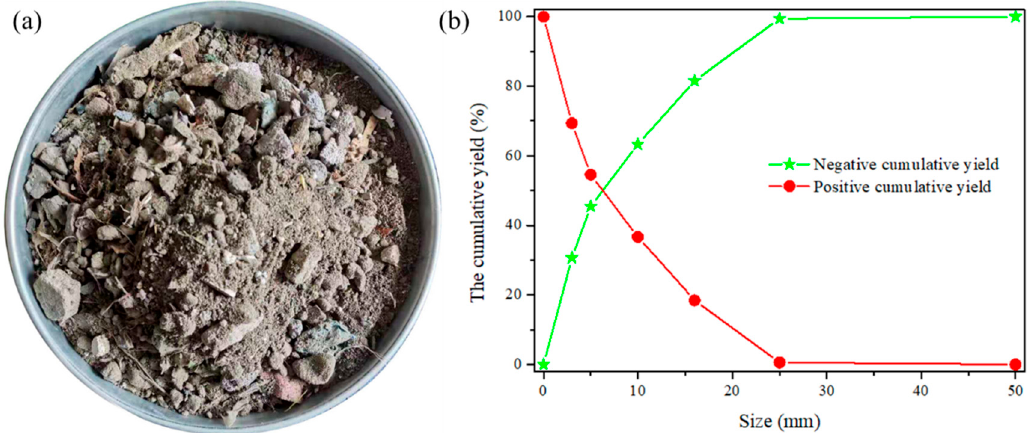
Figure 5. The (a) raw materials and (b) cumulative grain size curves of samples. Figure 5. The ( a ) raw materials and ( b ) cumulative grain size curves of the samples.